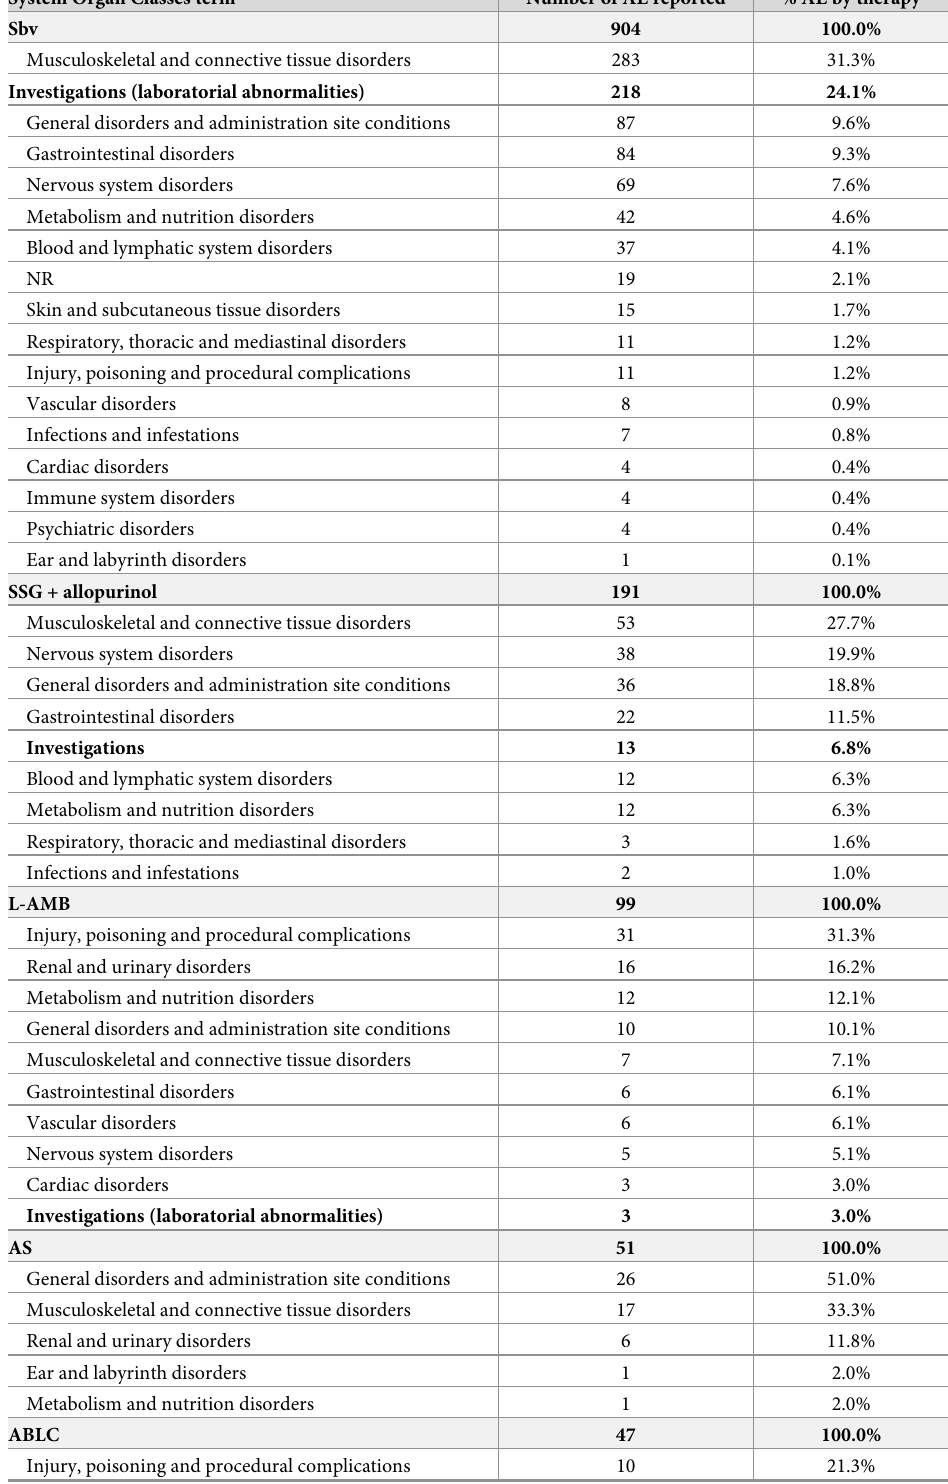
Table 4. System Organ Classes for adverse events according to